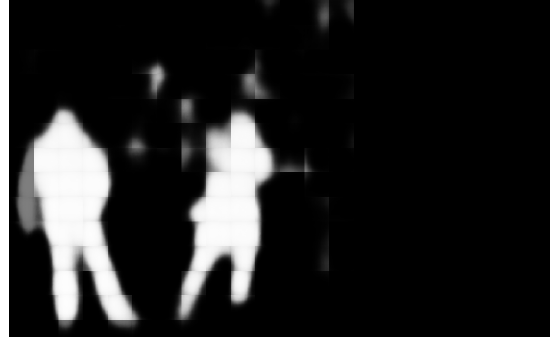
Figure 6. Image resultant of the combination of 64 × 64 grayscale patches obtained by CNN predictions.